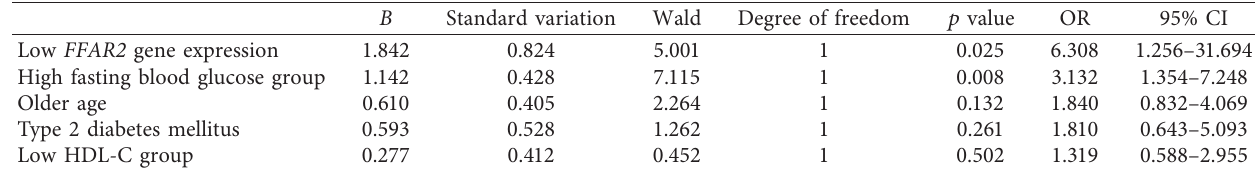
Table 5: Logistic regression analyses of independent risk factors for